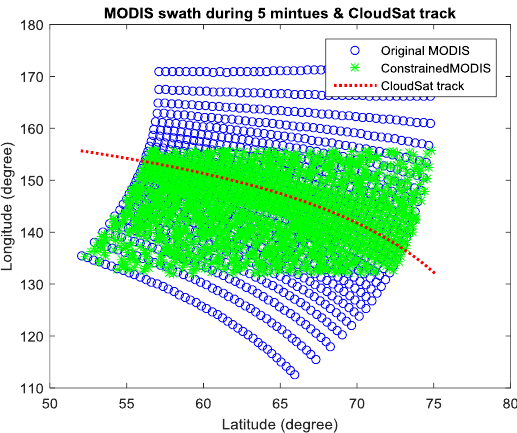
Figure 7. MODIS swath during five minutes, from 02:40 to 02:45, on 1 June 2015, and the overlapped CloudSat track, where the sparse sampling pixels of the granule have been plotted to reveal clear details. The circles represent the original MODIS granule, the overlapped asterisks are the selected MODIS granule, and the dotted line denotes the truncated CloudSat track.